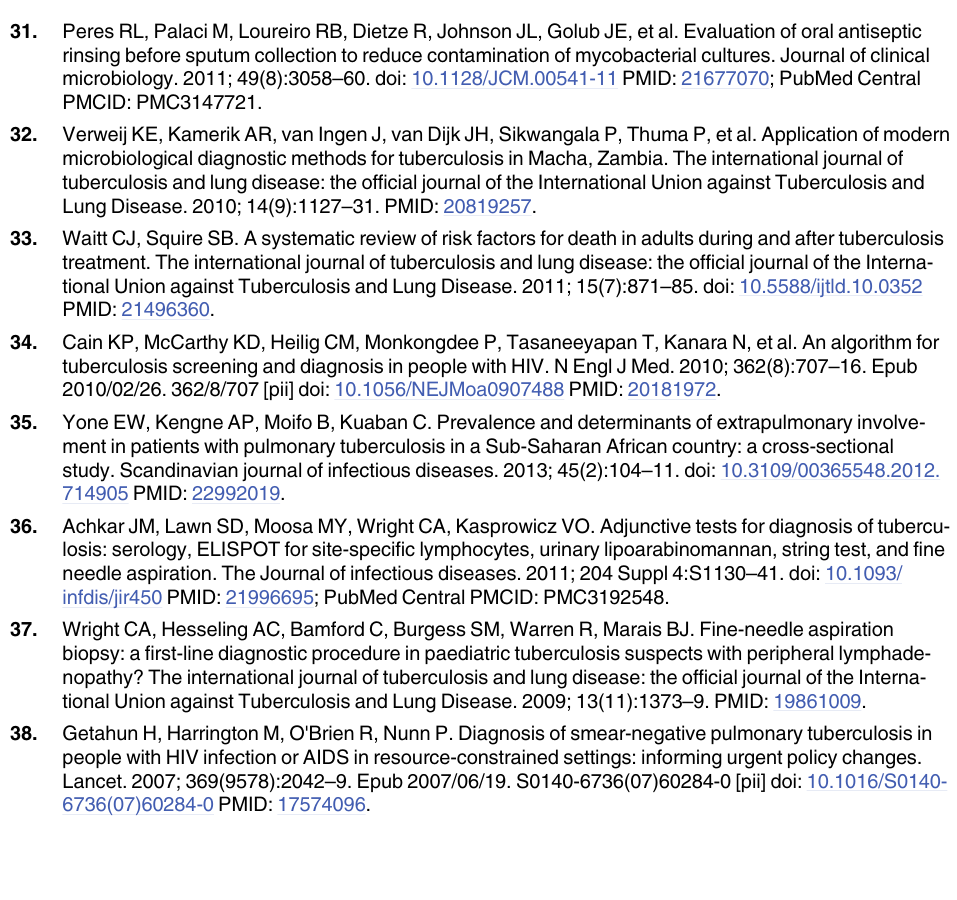
PLOS ONE | DOI:10.1371/journal.pone.0152364 March 29,